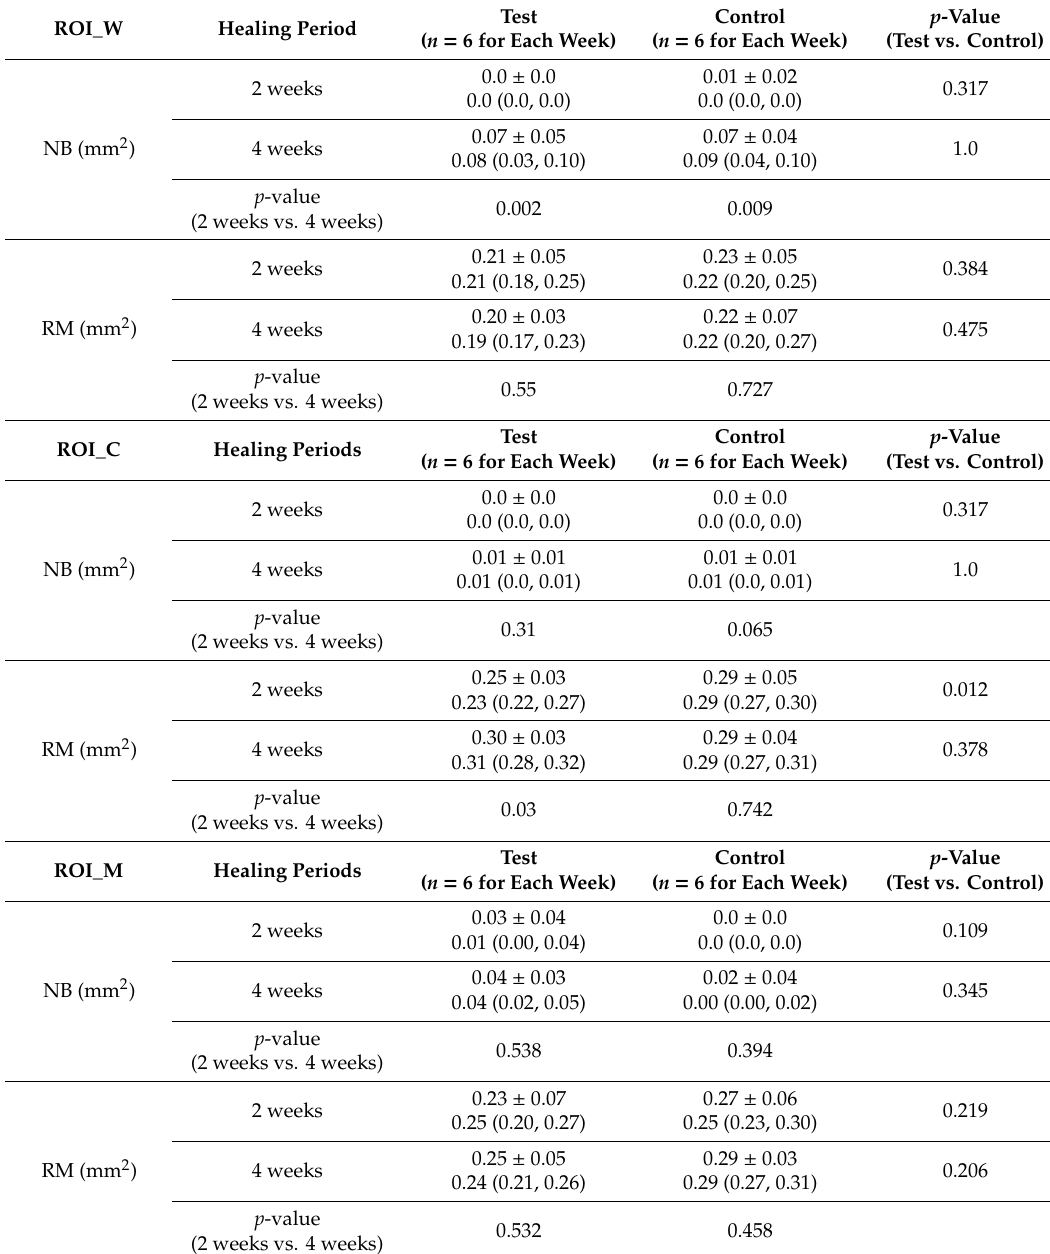
Table 2. Amount of newly formed bone and residual bone substitute material in regions of interest (ROI = 0.64 mm 2